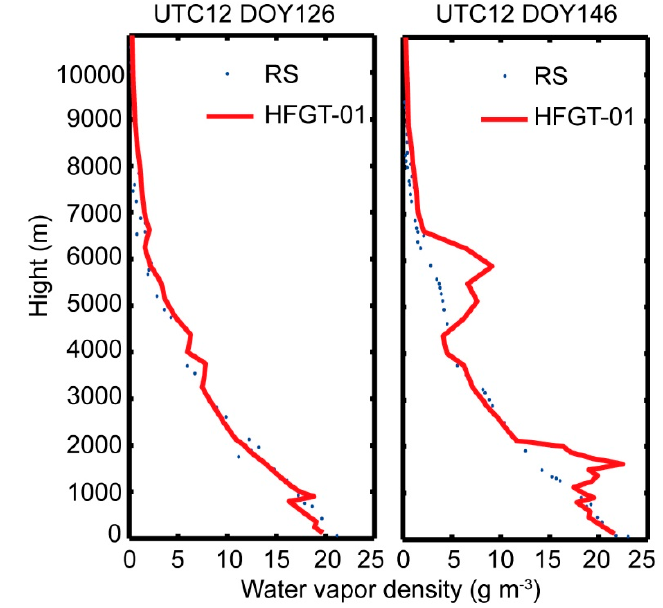
Figure 11. Water vapor profiles (red curves) obtained from HFGT-01 compare against that of radiosonde data (RS) (blue points) on DOY 126 and DOY 146.